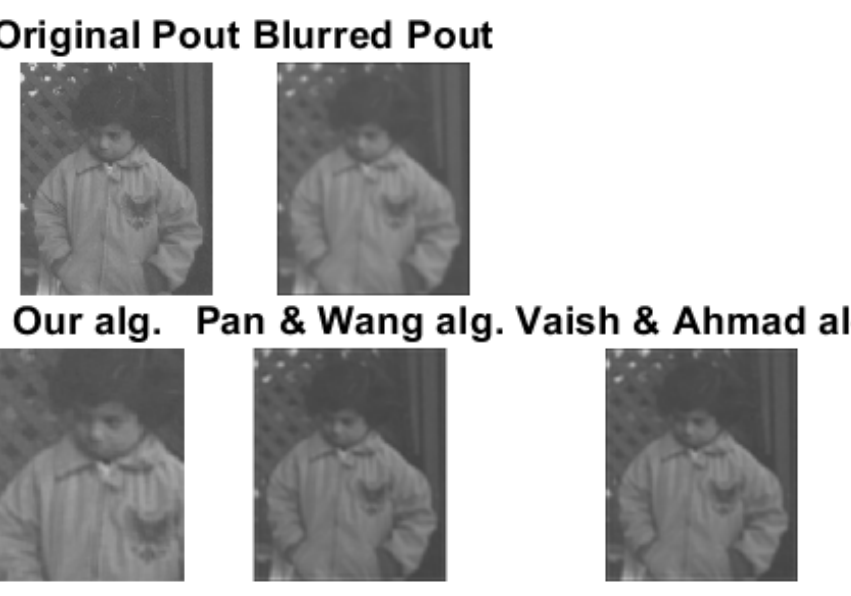
Figure 4. Example 2. The top row shows the original Pout image ( left ) and the degraded Pout image ( right ). The bottom row shows the images recovered by our algorithm, by that of Pan and Wang, and by that of Vaish and Ahmad.